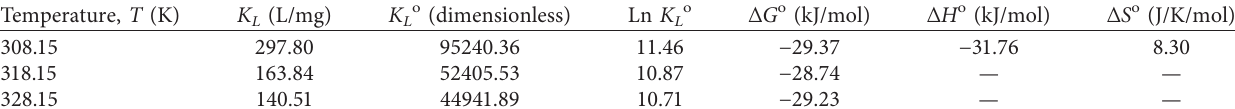
Table 5: Thermodynamical parameters for MB adsorption onto HAP:BENT (24 mg) adsorbent. Temperature, T (K)